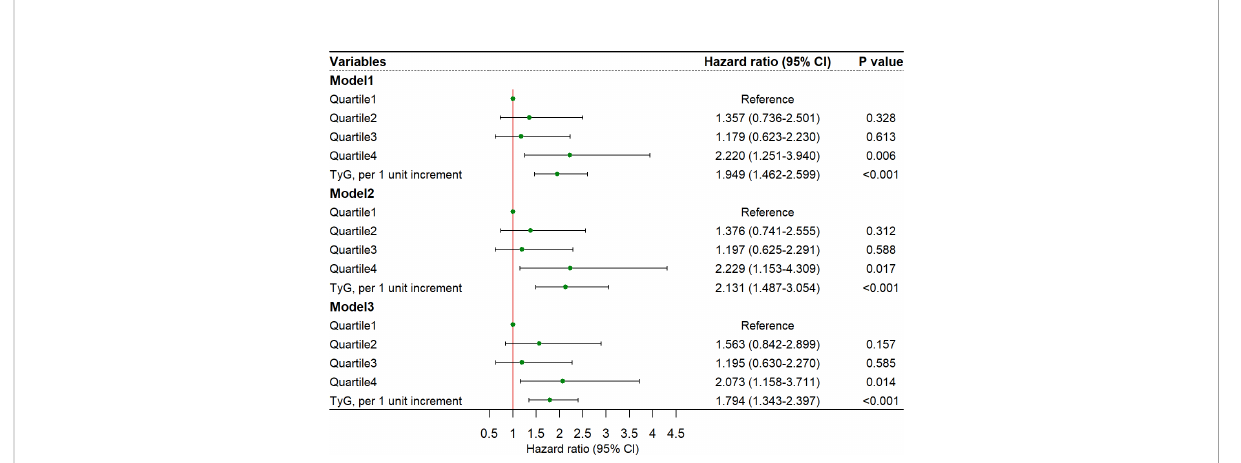
FIGURE 2 Risk of stroke recurrence in elderly patients for TyG index. CI, con fi dence interval, TyG, triglyceride-glucose index. Model 1: adjusted for age and sex. Model 2: adjusted for age, sex, hypertension, diabetes mellitus, smoking status, drinking, coronary heart disease, atrial fi brillation, antiplatelet drug, anticoagulant, statin, antihypertensive drug and hypoglycemic agent. Model 3: adjusted for variables included in the back-ward selection method: age, high density lipoprotein, homocysteine, annual family income, anticoagulants and stroke